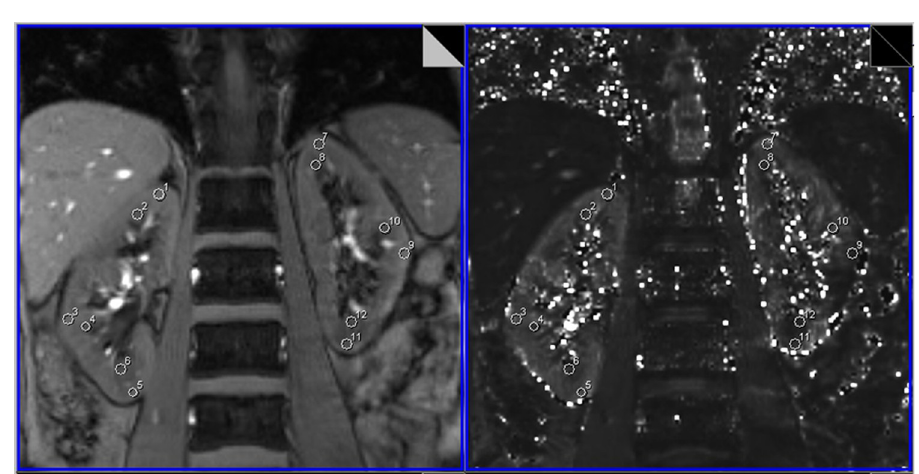
Fig 2. A 51-year-old woman with a severe renal artery stenosis of left kidney. ROIs were drawn in the original BOLD image and T2 � mapping simultaneously. T2 � mapping showed multiple low-signal regions in the left kidney. R2 � values (relaxation rates) for the patient were high.